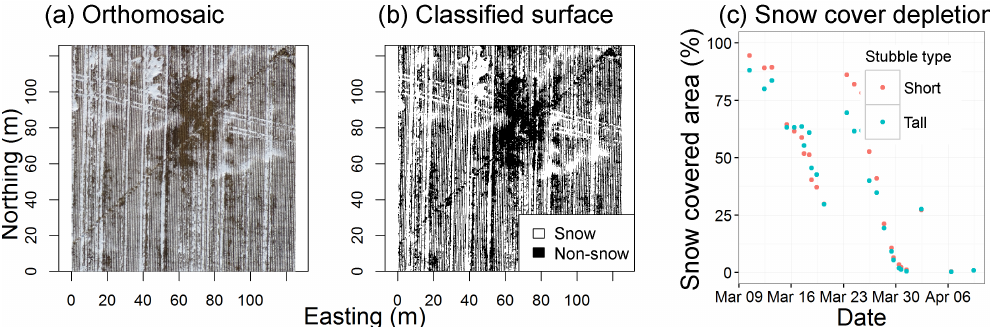
Figure 8. Estimation of snow-covered area requires (a) an orthomosaic which is then (b) classified into snow and non-snow-covered area. This produces (c) a snow cover depletion curve when a sequence of orthomosaics is available. The short and tall stubble surface snow-covered areas at the prairie site are contrasted, with a snowfall event evident on 23 March 2015.